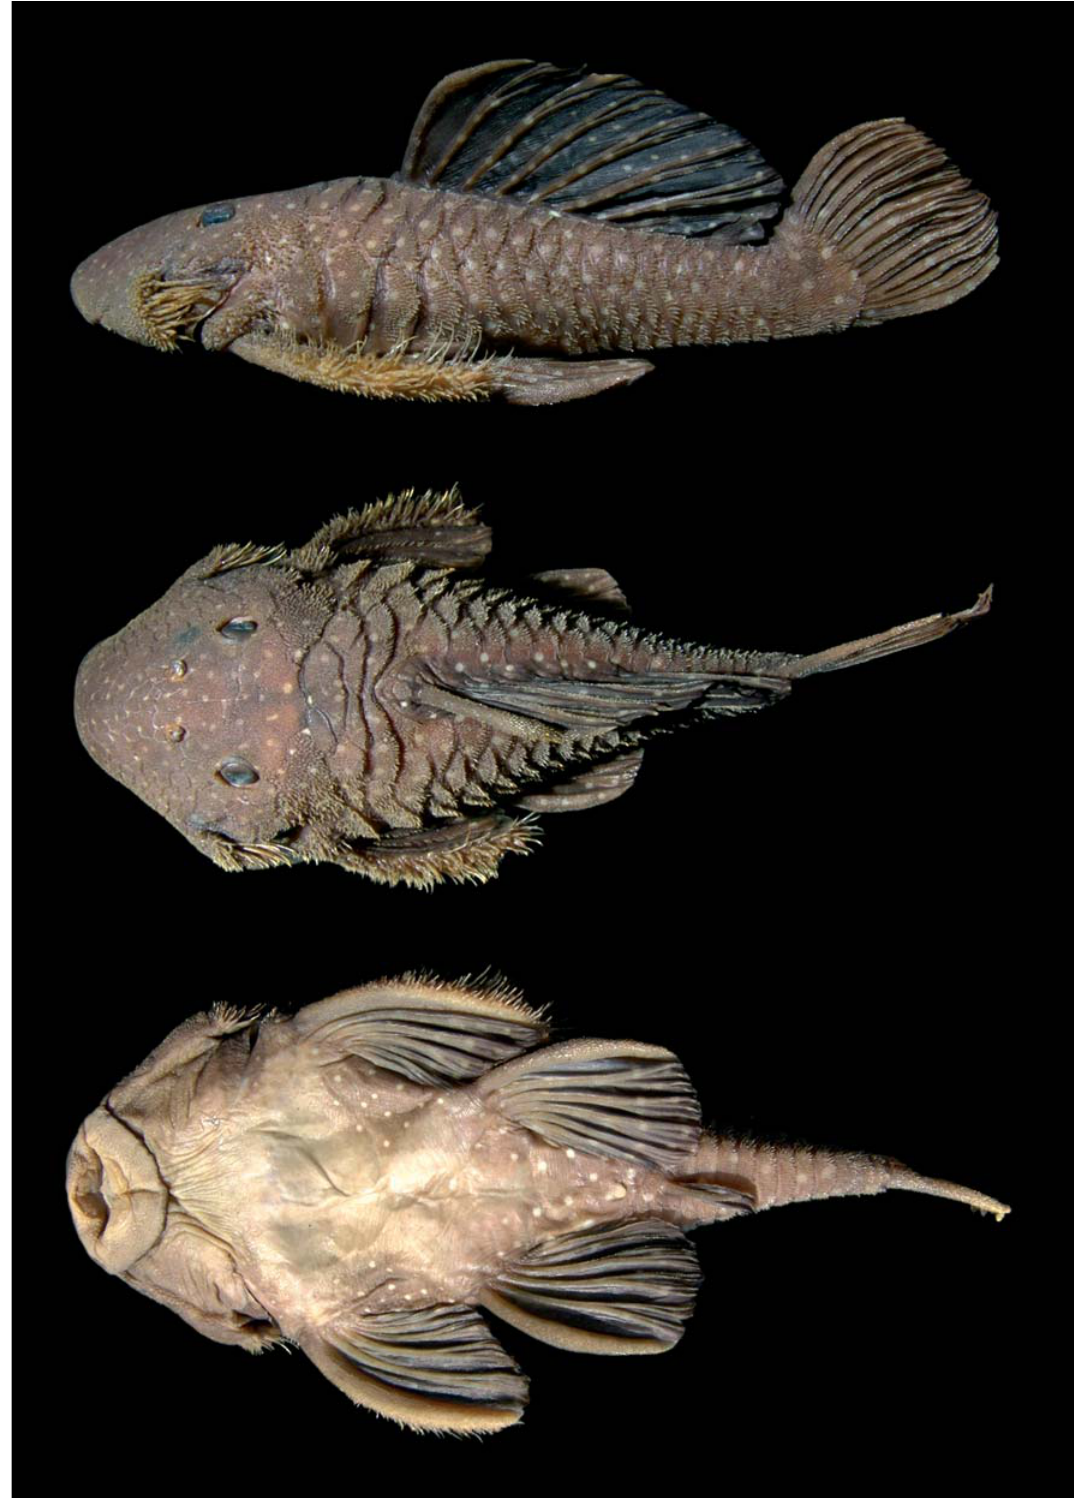
Fig. 1. Parancistrus nudiventris . Lateral, dorsal, and ventral view of the holotype (INPA 15037, 152 mm